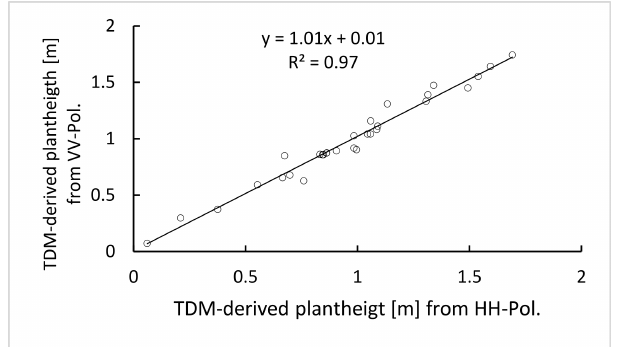
Figure 8. Mean height values from HH- and VV-Polarisations over of the maize fields of the region, generated from the TDM acquisitions No. 1 and 2 (Table 1) (n = 30).